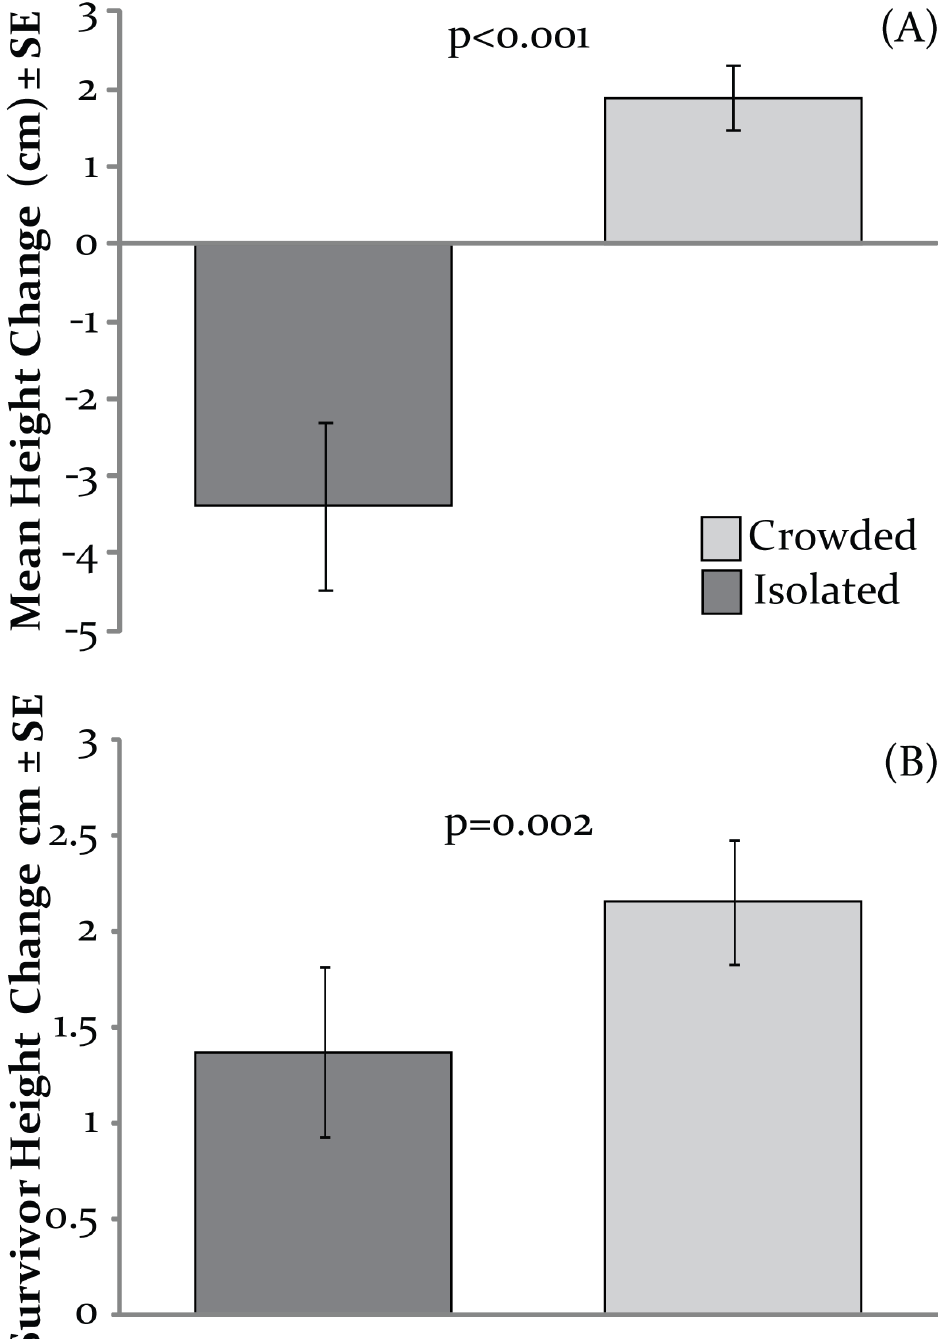
Fig 4. Growth ofmature S . polycystum fronds transplanted into or outside Sargassum beds. (A) Data for all the transplanted fronds (n = 20), presented p-value is from a Wilcoxon signed-rank test(B)Data restricted to fronds that survived the entire experiment (n = 16), presented p-value is from a paired